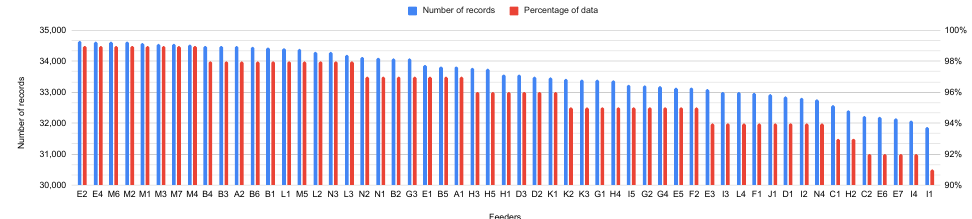
Figure 2. Combo bar chart representing the number and percentage of records per